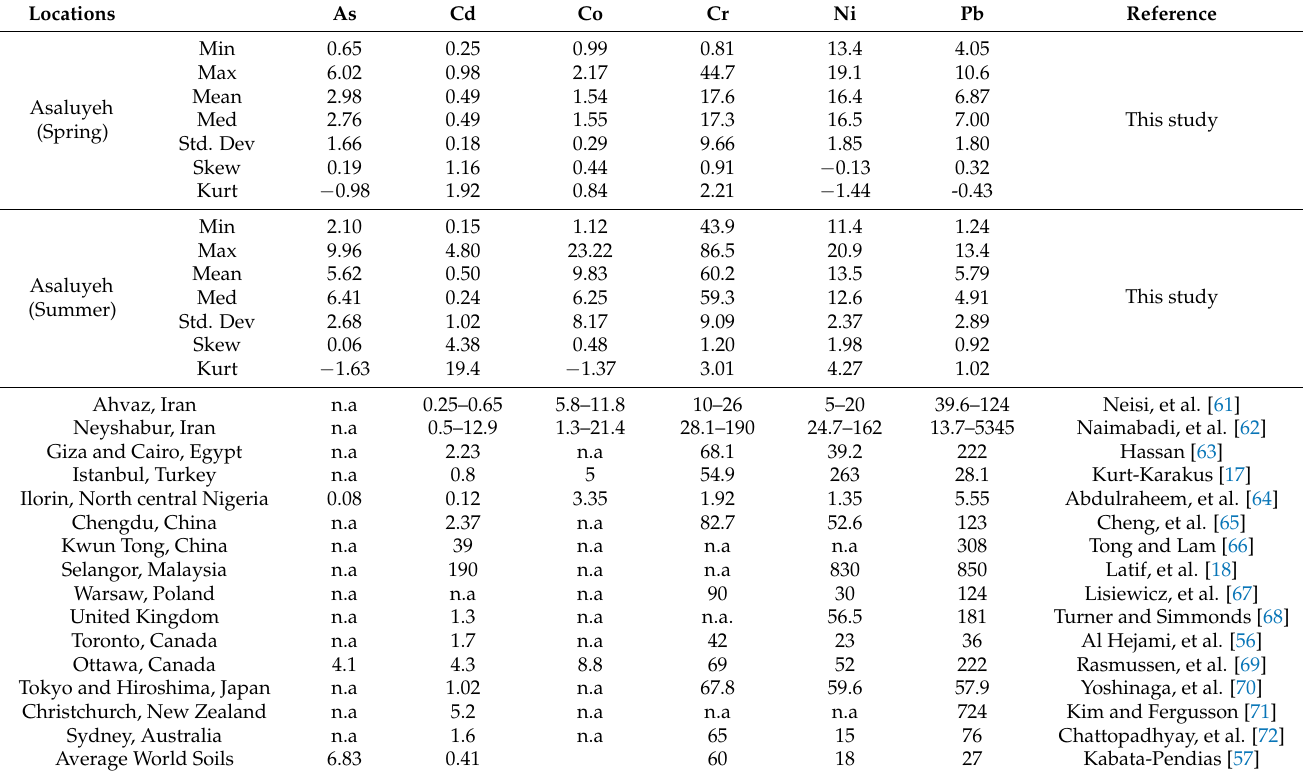
Table 1. Total concentrations of heavy metals (mg kg − 1 , dry weight) from indoor dust samples in Asaluyeh and other urban areas, and for average global